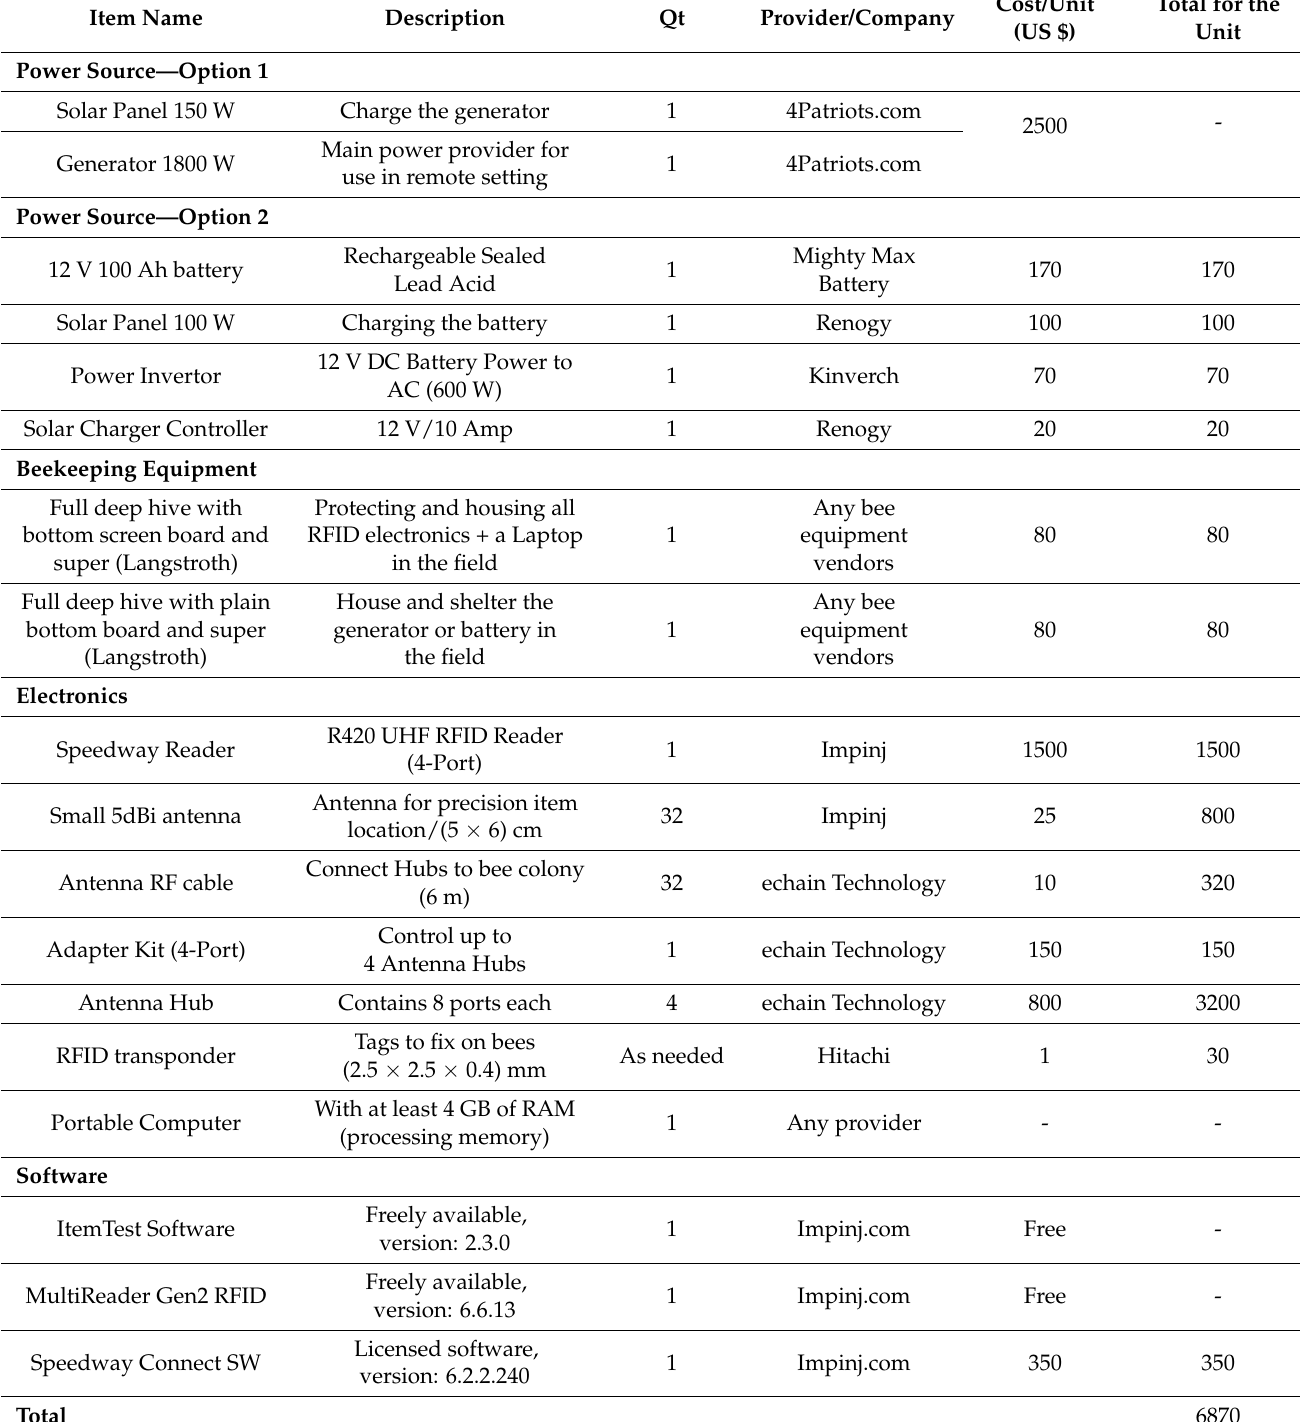
Table 1. Description of all hardware and software required to build the 32-antenna RFID unit used to track honey bee activity and behavior in the field. Provider and vendor names are given for the sole purpose of identifying the products used in this